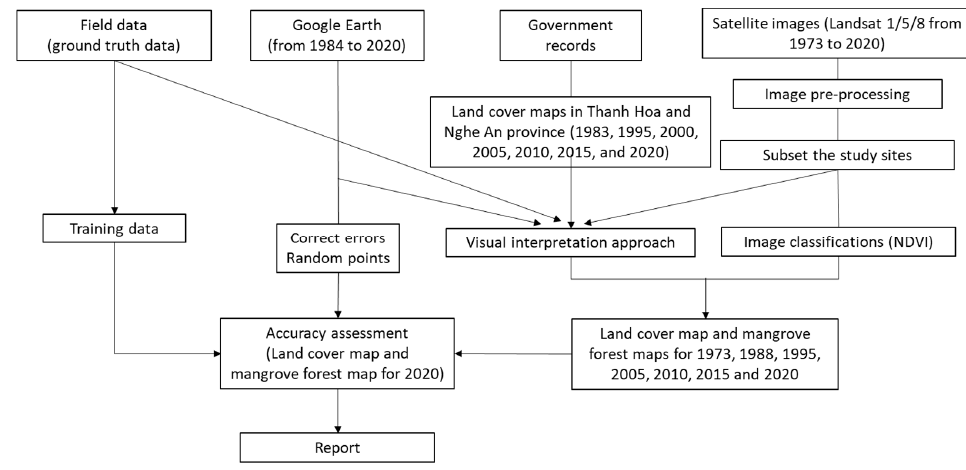
Figure 2. Chart of the methodology used for mapping mangrove extent and land